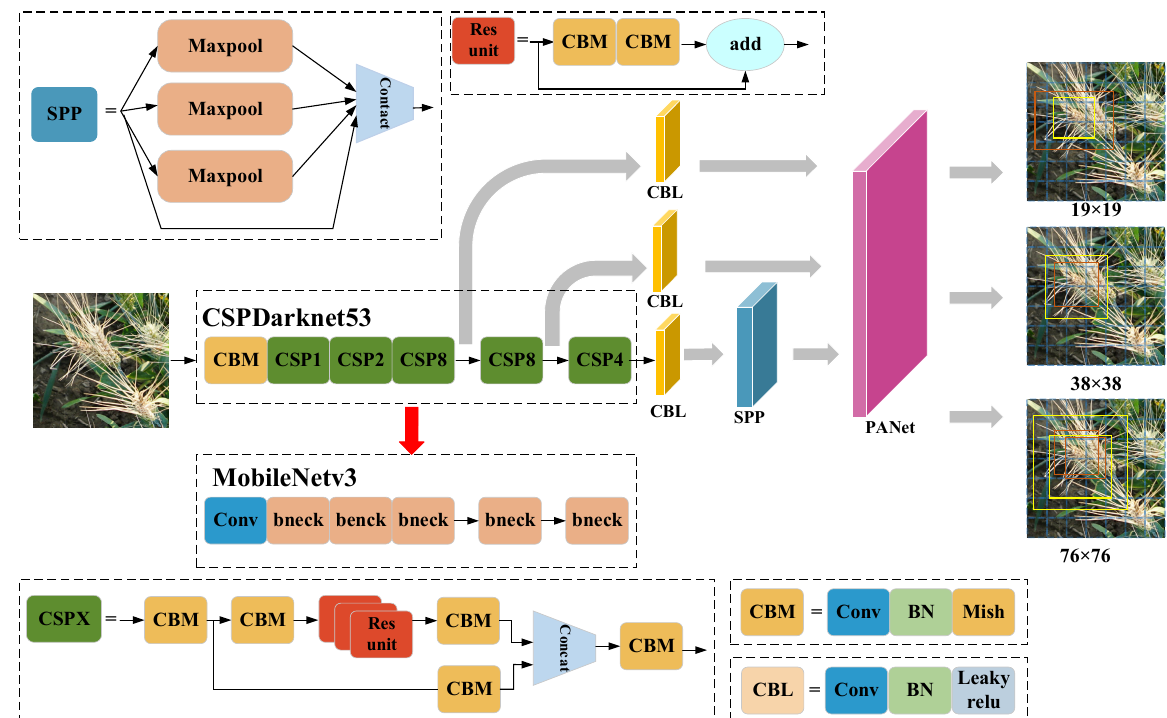
Figure 6. The proposed lightweight network structure based on the YOLOv4.